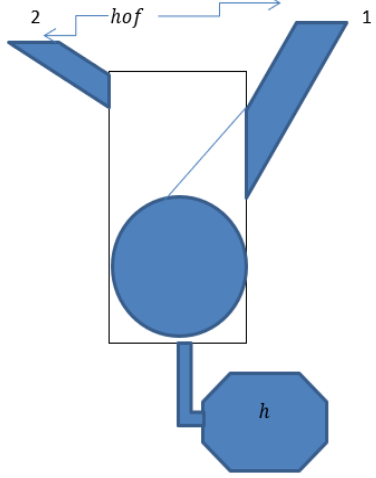
Figure 4. The composition 𝜐𝜊𝑓 explains when 𝑓 is entered from pipe 2.